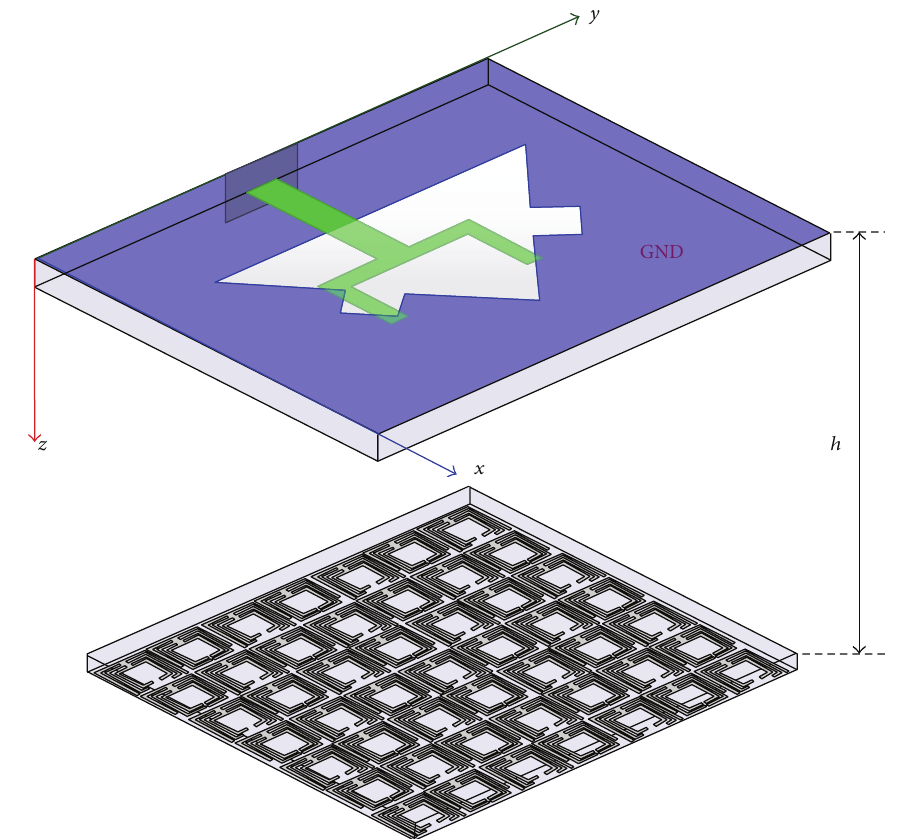
Figure 6: Configuration of the slot antenna with the proposed FSS